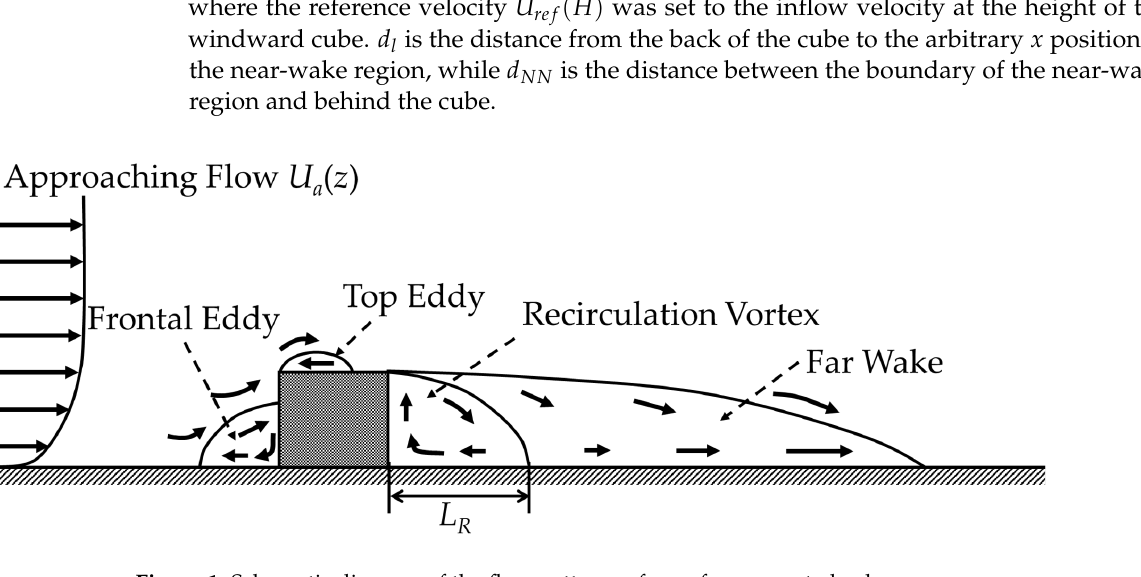
Figure 1. Schematic diagram of the flow patterns of a surface-mounted